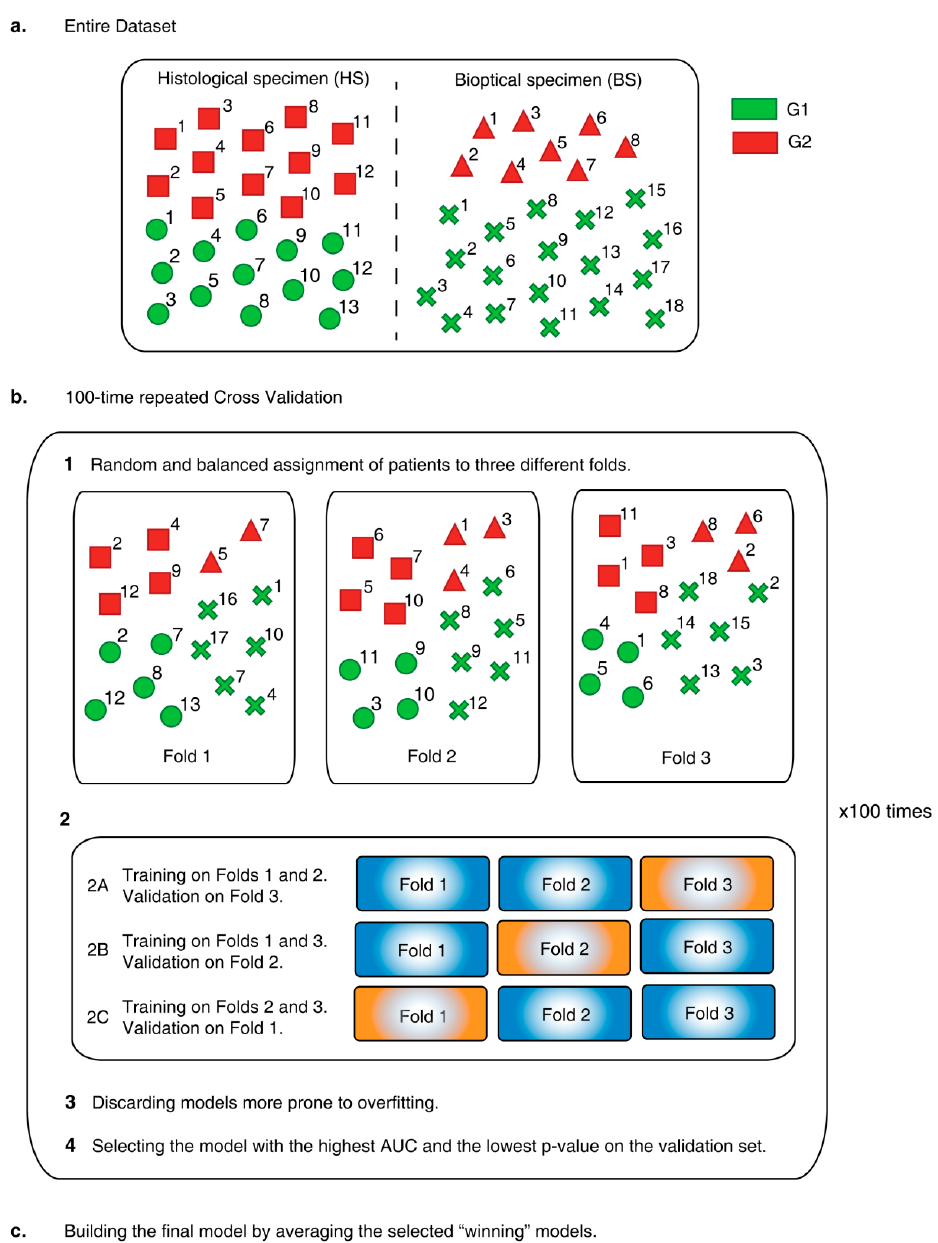
Figure 2. The procedure adopted to build model C starting from a “mixed” population ( a ) of patients with grade 1 (G1) and 2 (G2) pancreatic neuroendocrine neoplasia assessed through the analysis of histological (HS) or biopsy (BS) samples is described. In particular, repeated cross validation is applied 100 times to extract as many radiomic models trained and tested on randomly selected and balanced groups of patients ( b ) and exploited to build the final radiomic model ( c ).